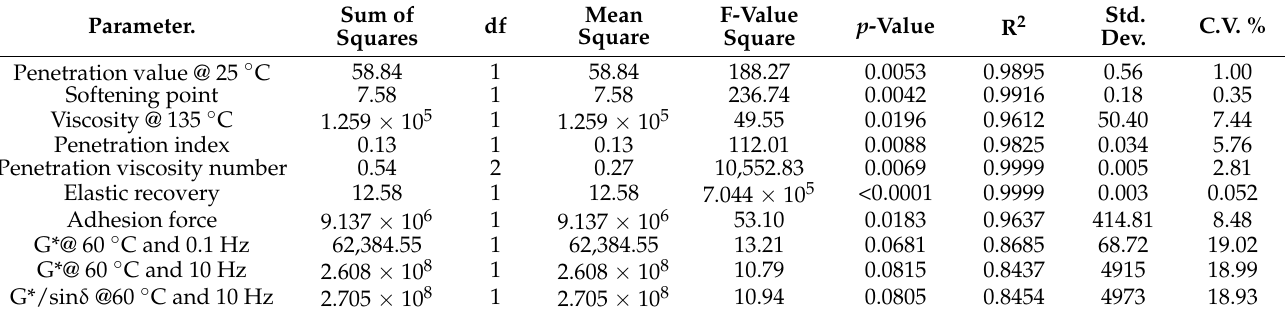
Table 4. Analysis of variance results summary at various CNFs